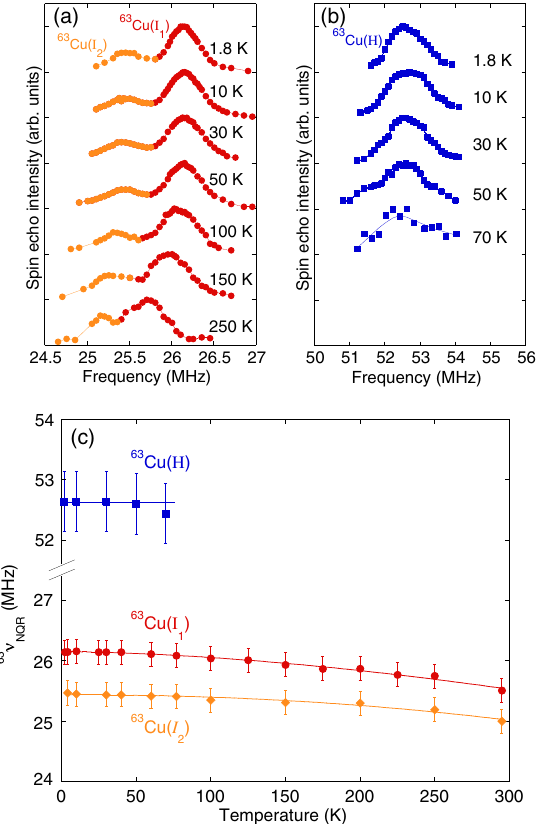
FIG. 4. (a),(b) 63 Cu NQR peaks observed for the 63 Cu ð I 1 ; 2 Þ and 63 Cu ð H Þ sites at selected temperatures. For clarity, the origin of the vertical axis is shifted at different temperatures, and the peak intensity is normalized to 1. (c) Temperature dependence of Na 0 SnO 3 , which . 5 . 5 63 ν . All solid lines are a guide for the eyes. NQR